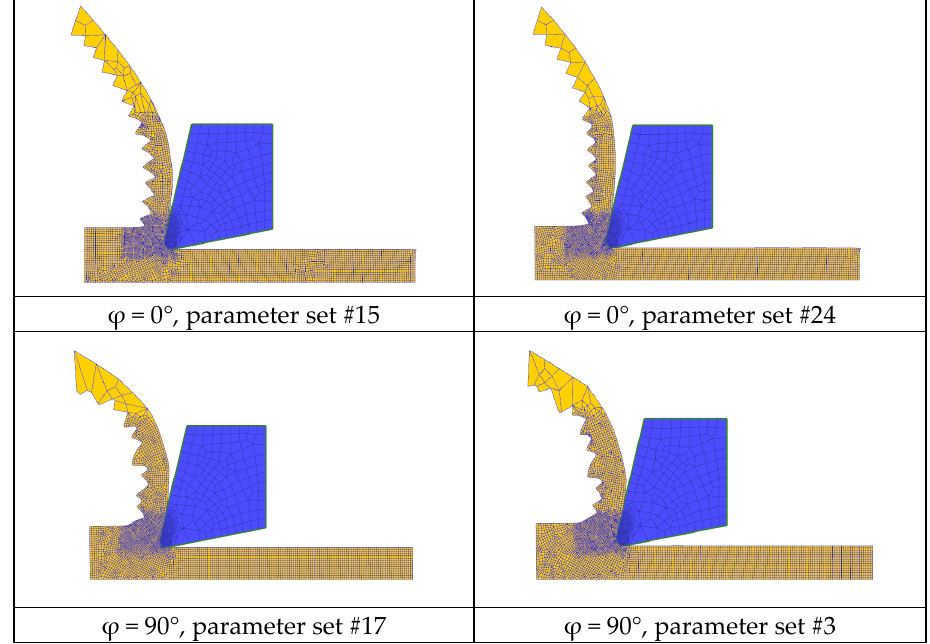
Figure 8. Simulation results depending on the built-up angle φ and different parameter sets.